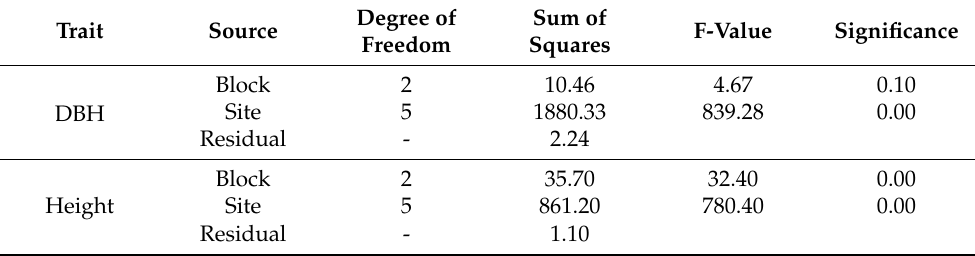
Table 3. The fixed Table 3. The fixed effect.